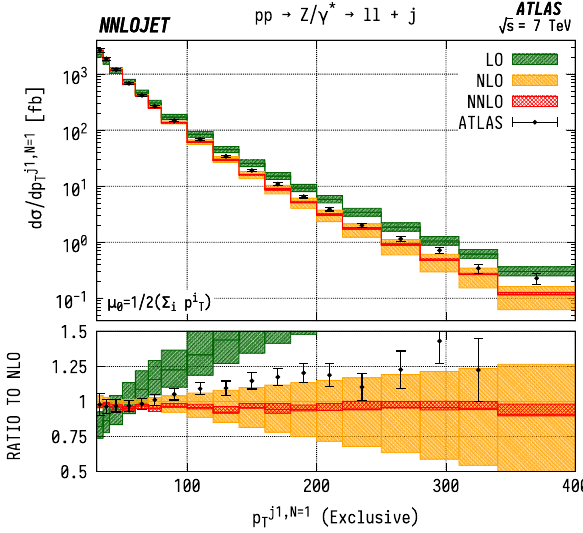
Fig. 15 ZJ cross section differential in the transverse momentum p T of the leading jet for events with exactly one associated jet ( N = 1 ) . PredictionsatLO(green),NLO(orange),andNNLO(red)arecompared to ATLAS data from Ref. [7], and the ratio to NLO is shown in the lower panel. The bands correspond to scale uncertainties estimated as described in the main